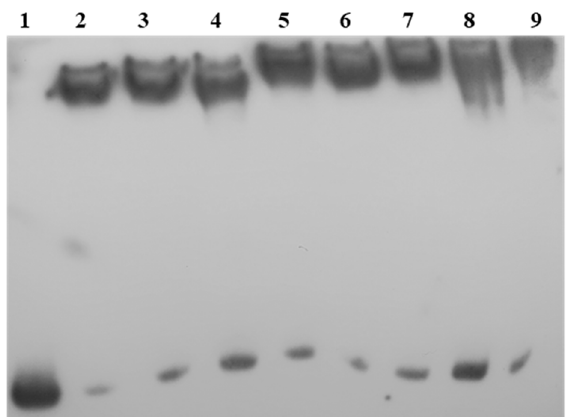
Figure 4. The binding ability of LkDHNs to different DNA probes was analyzed by